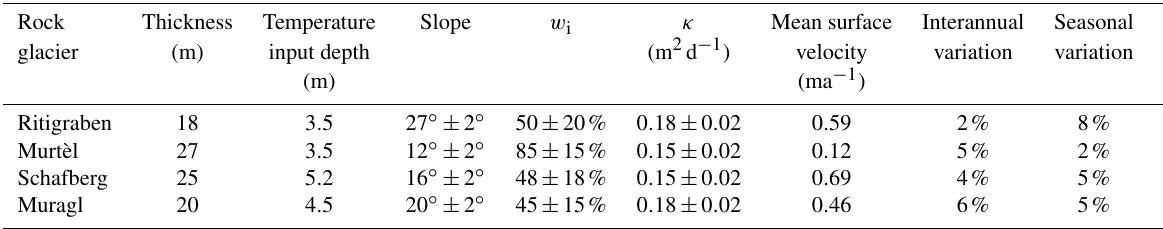
Table 2. Summary of modelling inputs and results. Values of geometrical and physical input parameters for the modelling are listed (thick- ness, slope, volumetric ice content and thermal diffusivity). The mean modelled surface velocity and its relative interannual and seasonal variations are reported in the last three columns.